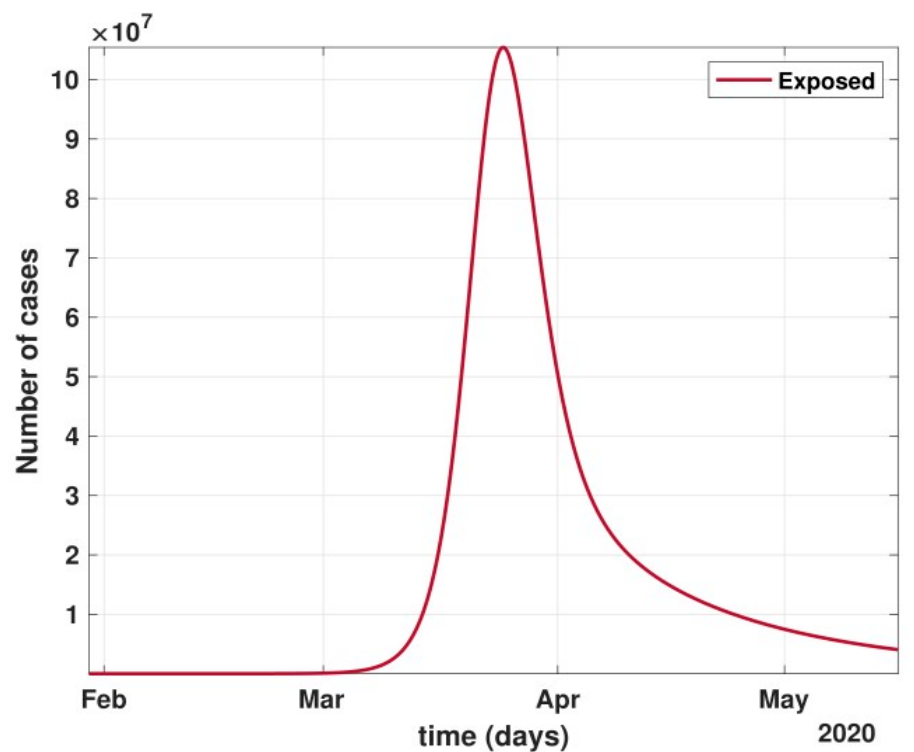
Figure 9. Number of cases in the Latent/Carrier class dropped significantly during April and May, i.e., the period of strict lockdown in India.